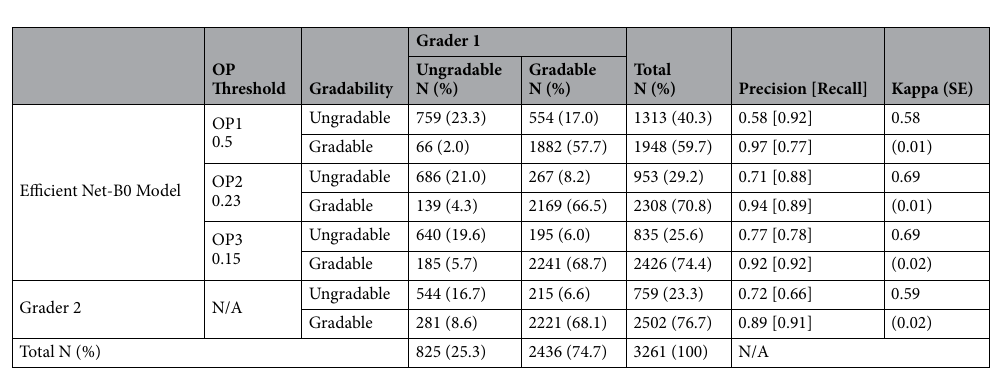
Figure 3. Compact Model (EfficientNet-B0) Gradability ROC and PR Curves. ROC Receiver operating characteristic, AUC-ROC Area under the receiver operating characteristic curve, AUC-PR Area under the precision recall curve, std. dev Standard deviation.